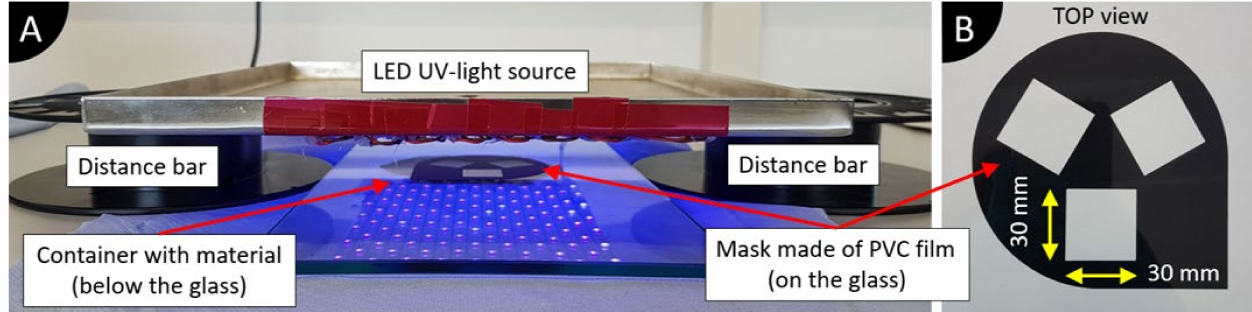
Figure 3. Curing setup used to manufacture rectangular specimens and to measure cure depth: ( A ) Curing setup; ( B ) Mask used to manufacture rectangular